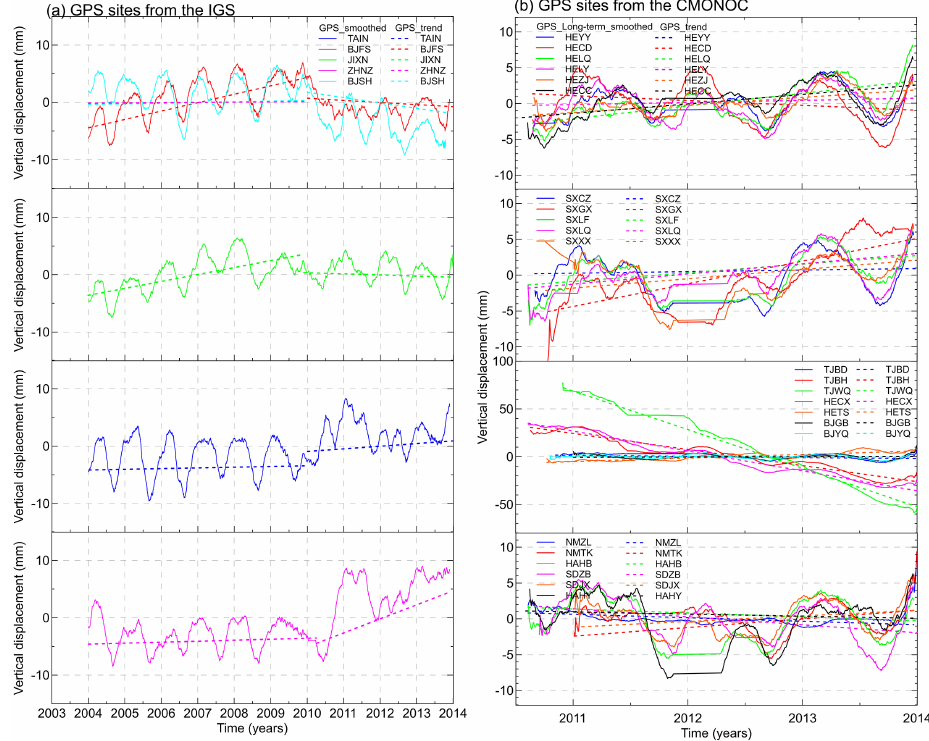
Figure 9. Smoothed (solid curves) and long-term (dash curves) versions of daily values of the vertical (positive upward) component of position, as measured at 29 GPS sites in NCP and its surrounding region, (a) five IGS stations and (b) 24 CMONOC